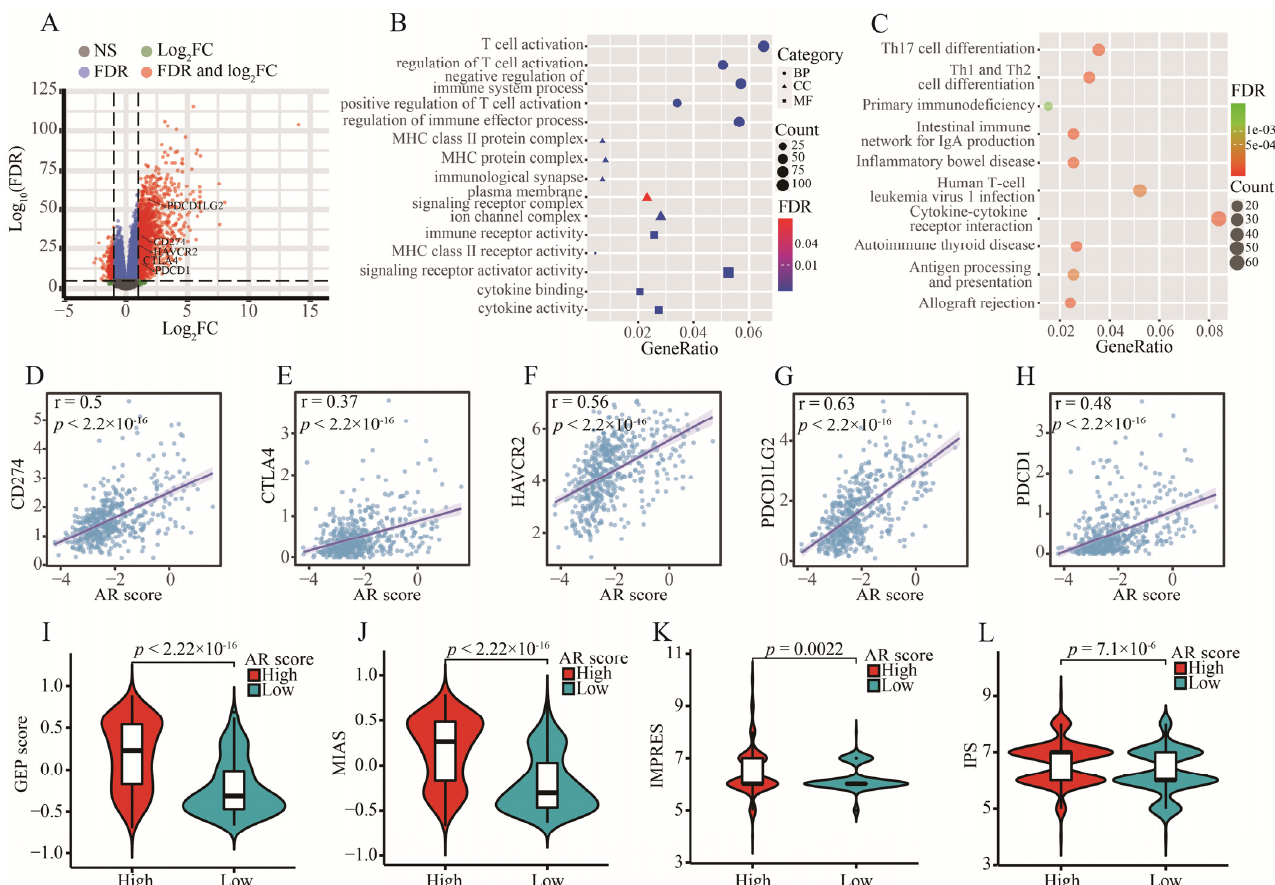
Figure 10. Prediction of immunotherapy using our signature. ( A ) The volcano plot of DEGs between high- and low-AR groups. ( B , C ) The GO and KEGG analyses of these DEGs between high- and low- AR groups. ( D – H ) The correlation of five ICs (CD274, CTLA4, HAVCR2, PDCD1LG2 and PDCD1) with AR scores. ( I – L ) The expression of four ICI-related indicators (GEP, MIAS, IMPRES and IPS) between high- and low-AR groups.